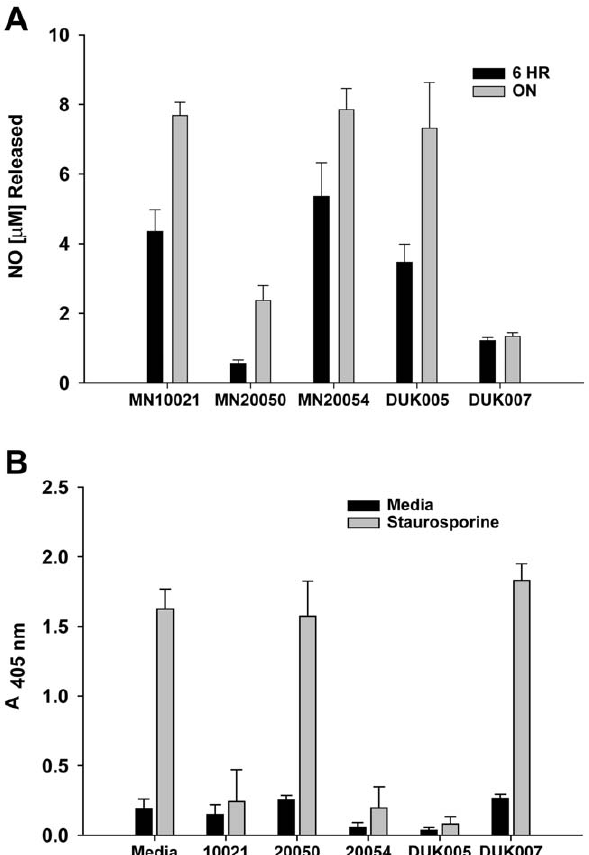
Figure 11. Inhibition of apoptosis in HUVEC correlates with production of NO by retroviral-derived peptides. A. HUVEC were grown to 70–80% confluence in 96-well tissue culture plates. Media was removed from the wells and to each of quadruplicate wells was added 200 m l of either fresh media (untreated) or fresh media containing 50 m M of the indicated peptides (treated) and the cells incubated ON at 37 u C. Supernatant was removed from each well as assayed for total NO by measurement of nitrite with a Colorimetric Nitric Oxide Assay Kit (Oxford Biomedical Research; Oxford, MI) which employs nitrate reductase to convert nitrate to nitrite. B. HUVEC were grown to confluence in 96-well tissue culture plates. Media was removed from the wells and to each of quadruplicate wells was added 200 m l of either fresh media (untreated) or fresh media containing 50 m M of the indicated peptide (treated) and the cells incubated 3 h at 37 u C. To quadruplicate wells of both untreated and treated cells were added 20 m l of media or 20 m l of media containing 500 nM staurosporine. The plates were incubated overnight at 37 u C and the cells processed for measurement of apoptosis using the Cell Death Detection Assay (Roche Diagnostics) per the manufacturer’s instructions.